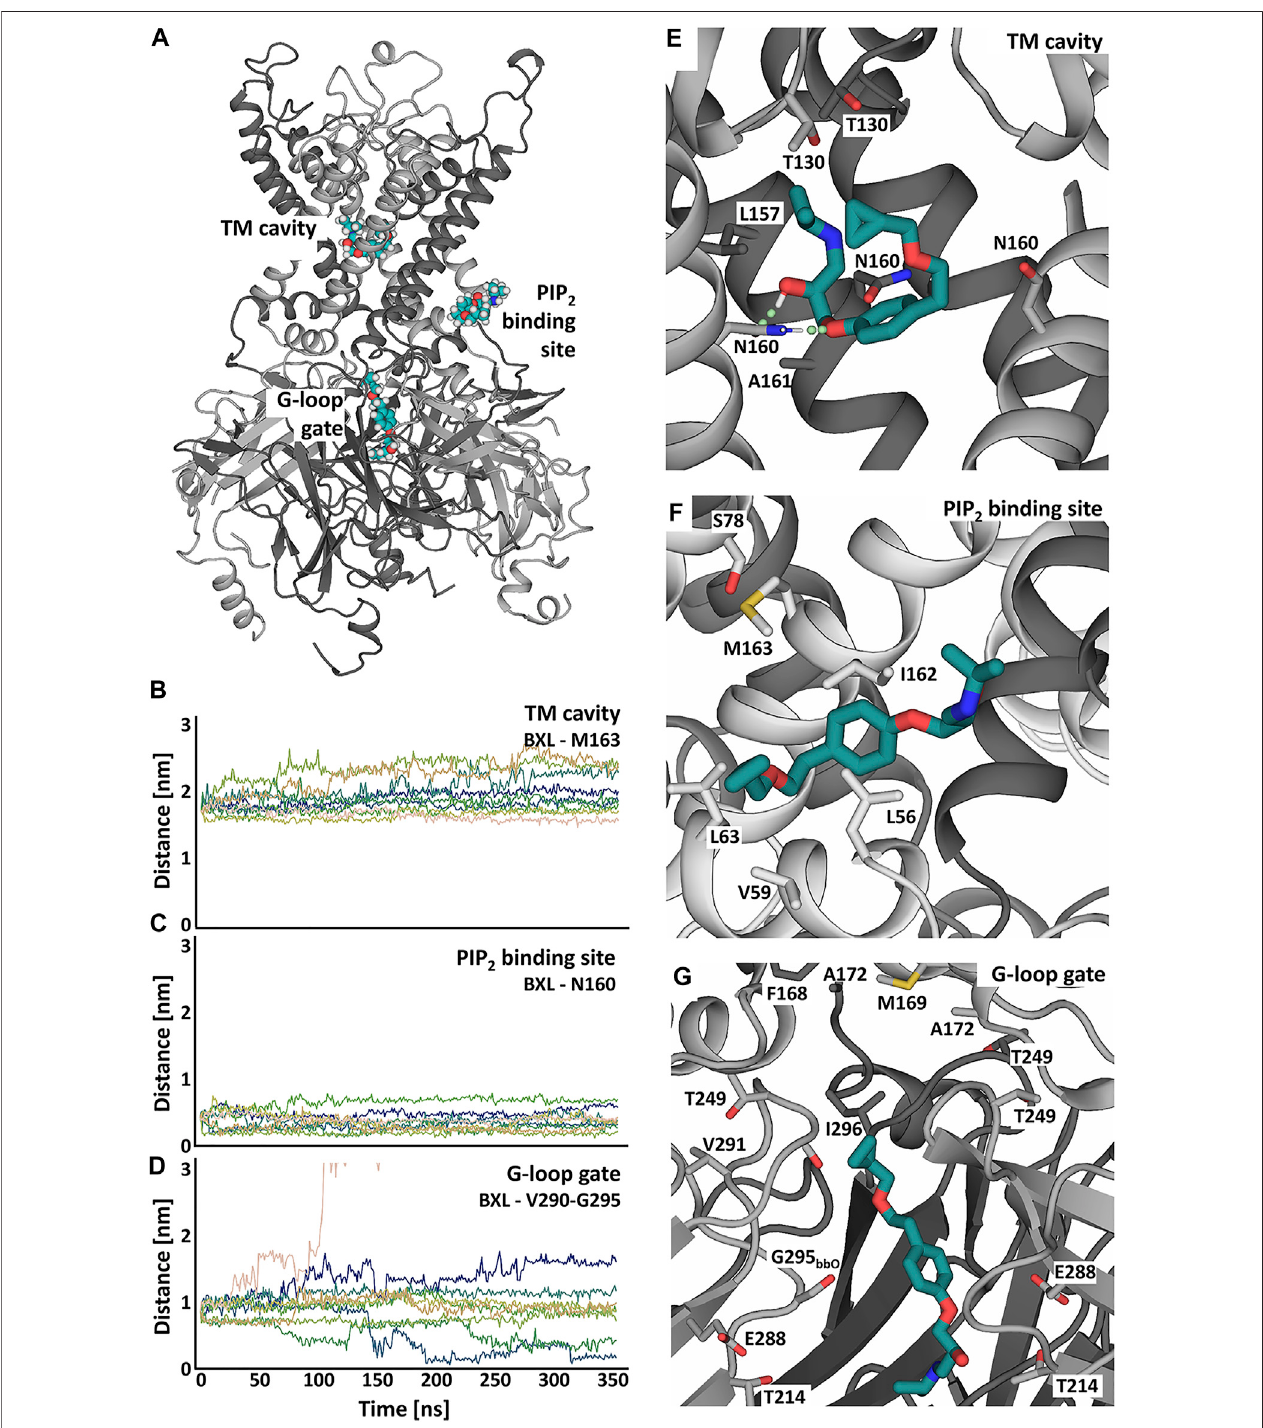
FIGURE 5 | Putative betaxolol binding sites and stability investigated in atomistic MD simulations with the K IR 6.2 channel pore. (A) Overview of the binding sites of betaxolol to the K IR channel pore. Different K IR subunits are shown in cartoon representation and colored in dark and light grey. The different betaxolol molecules are shown inteal. (B – D) Distances betweenbetaxololand theK IR 6.2channelin9replica of350ns-longMD simulations.Thedifferentlycoloredlines represent thedistances of the docked betaxolol molecules to the respective binding sites in the different runs. (E – G) Close-ups of the betaxolol binding sites at TM-cavity (E) , PIP 2 binding site (F) , G-loop gate (G) seen at the end of run1 of the all-atom MD simulations. The drug is shown as teal sticks, with hydrogen bonds shown as green dotted lines.